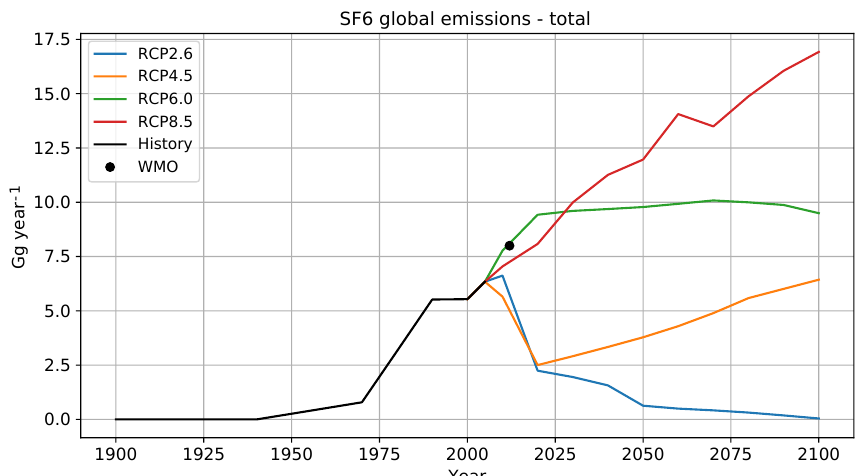
Figure 1. Time series of historical and projected global SF 6 emissions. Historical data cover 1900–2005 (black), and projections for the 2005–2100 time period correspond to four RCP scenarios with 2.6, 4.5, 6.0 and 8.5Wm − 2 radiative forcing in 2100 relative to pre-industrial values (Moss et al., 2010). The black dot is the annual growth of SF 6 in 2012 according to the WMO report (WMO,